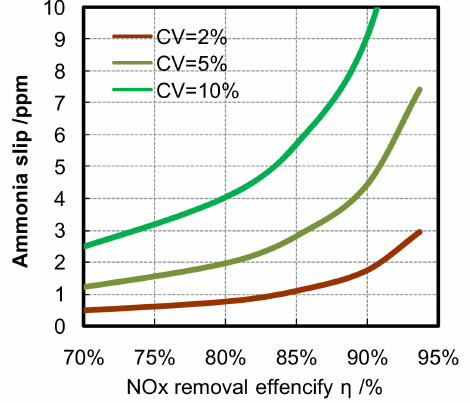
Figure 7. Quantitative relationship of the ammonia slip / De–NOX e ffi ciency and